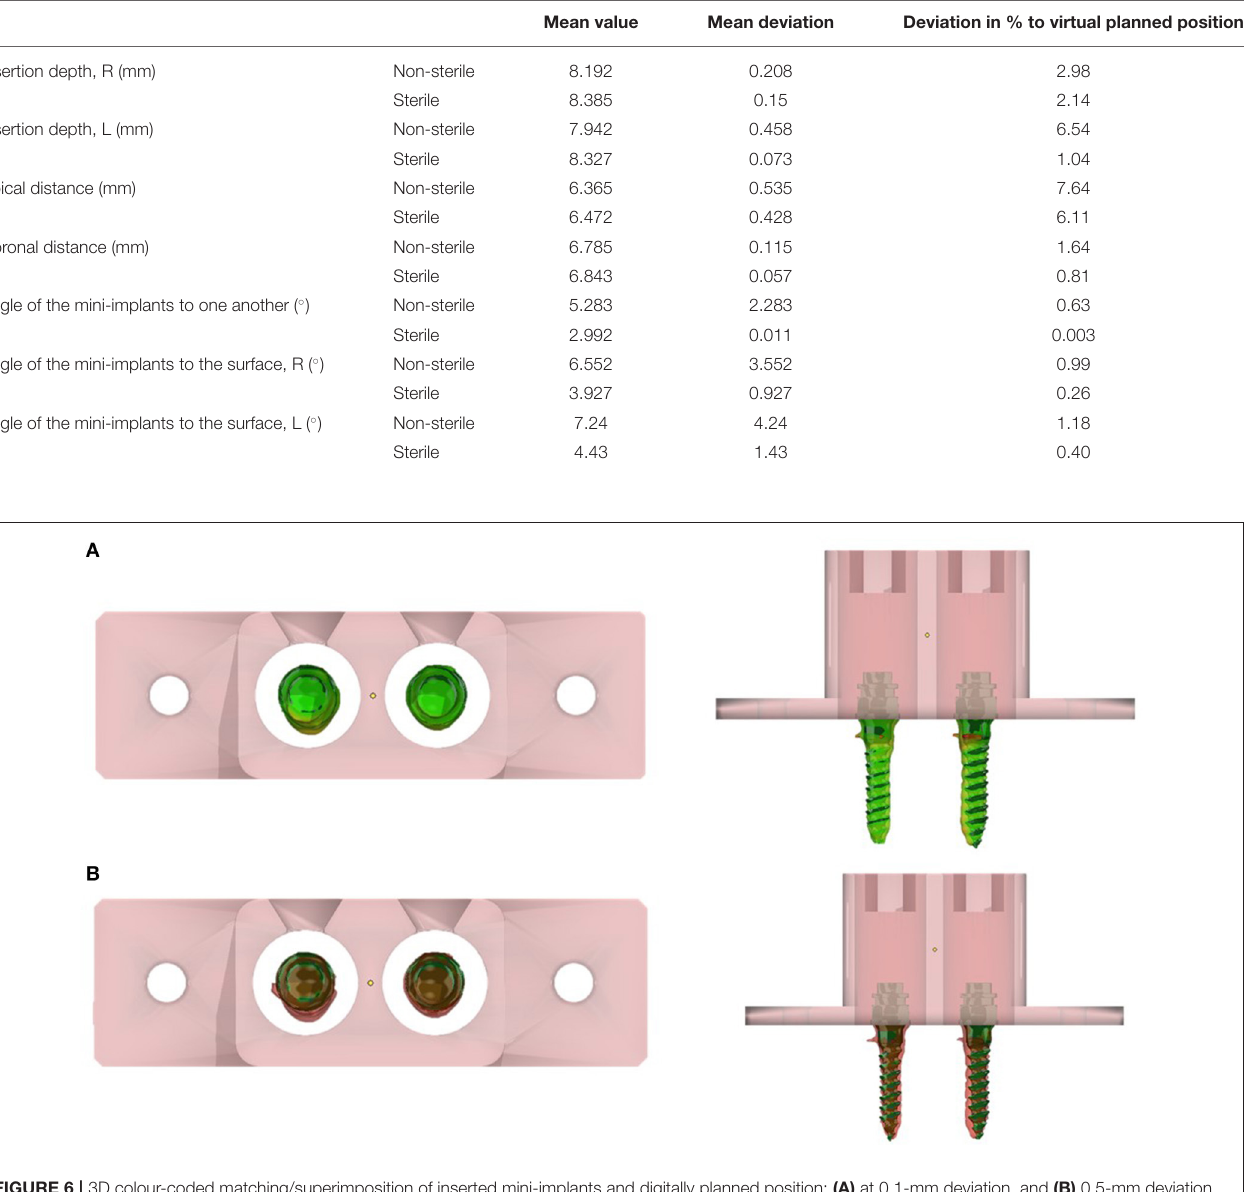
synthetic resin, or thermoforming films. Möhlhenrich et